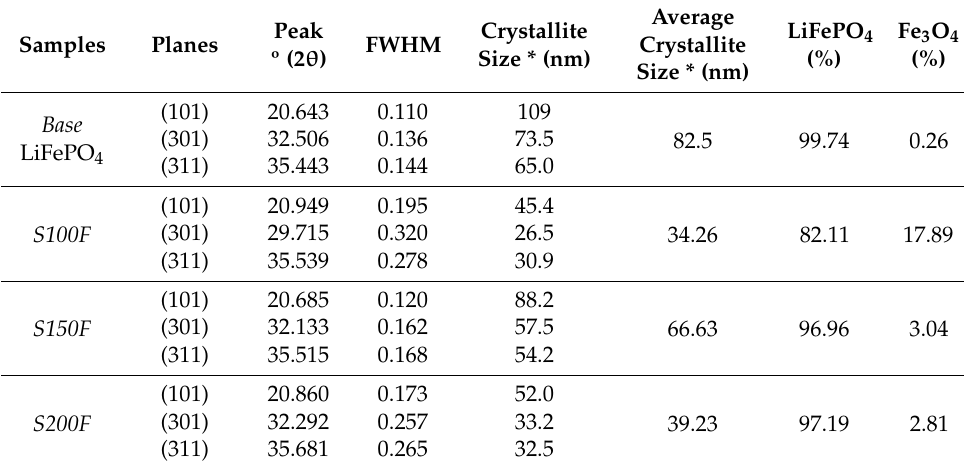
Table 4. Structural parameters derived from the XRD patterns the synthesized LiFePO 4 particles and Fe 3 O 4 impurity